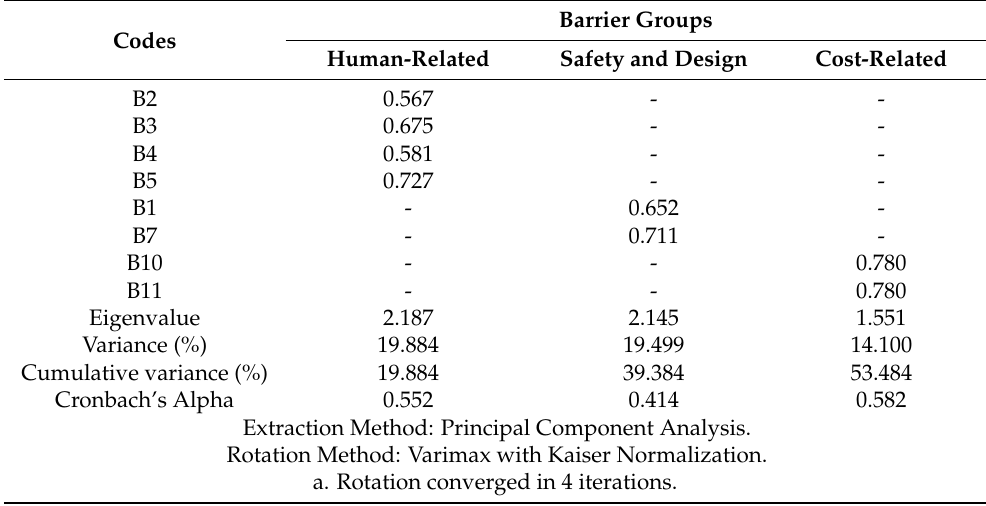
Table 6. Results of the rotated component matrix for factor analysis.